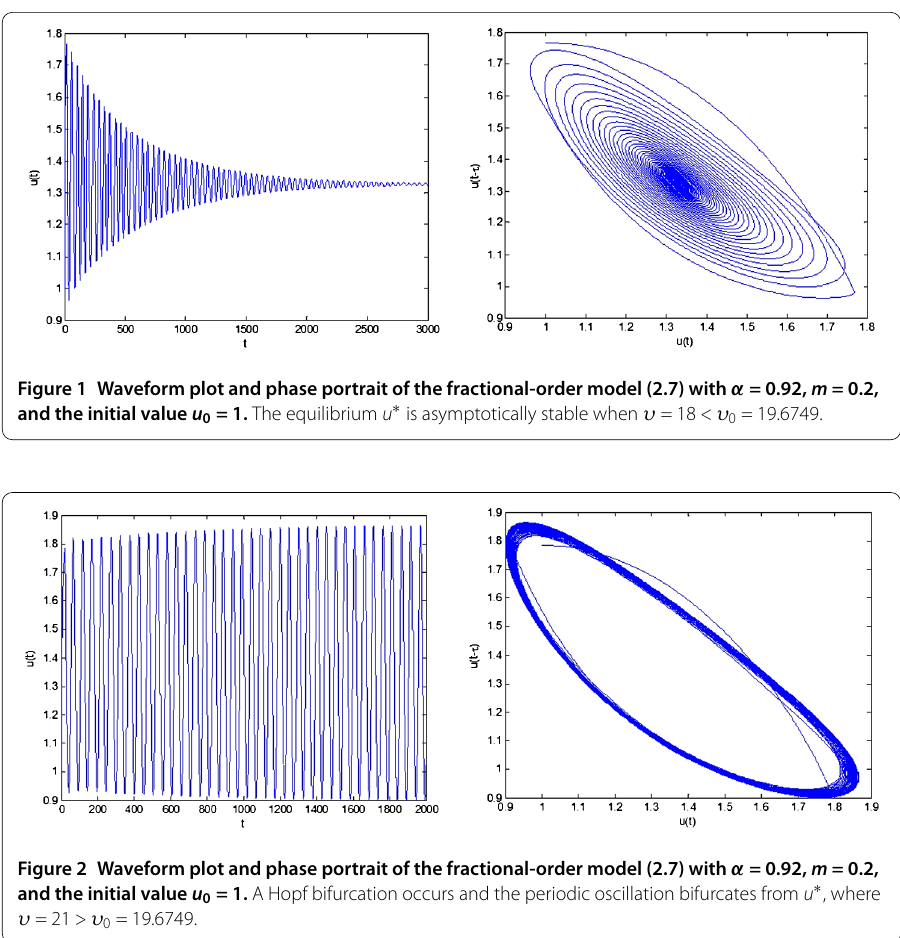
Table 1 Bifurcation point υ 0 versus fractional order α for model (2.7)